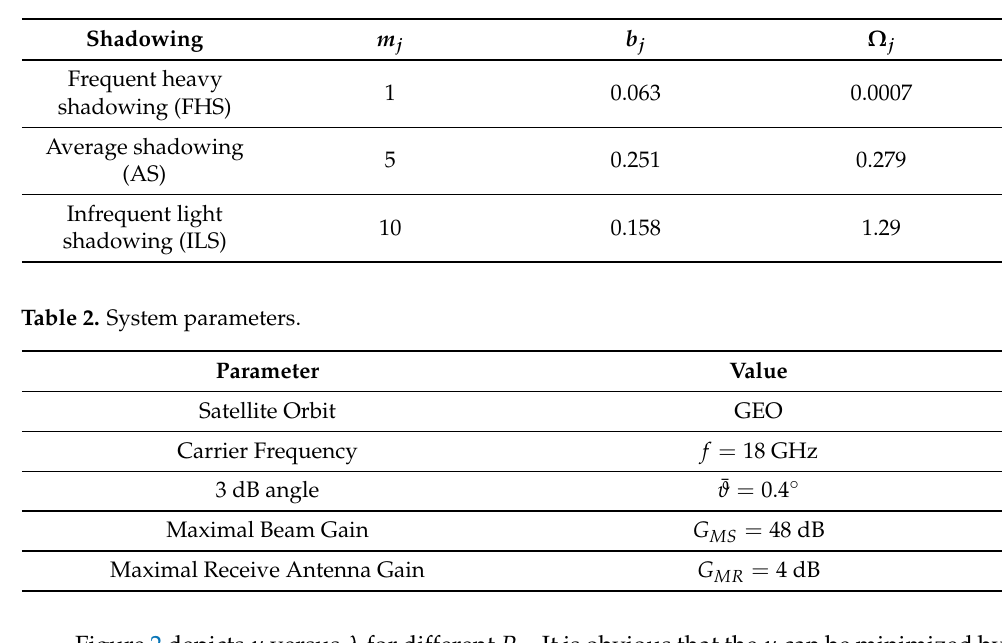
Table 1. Channel parameters.